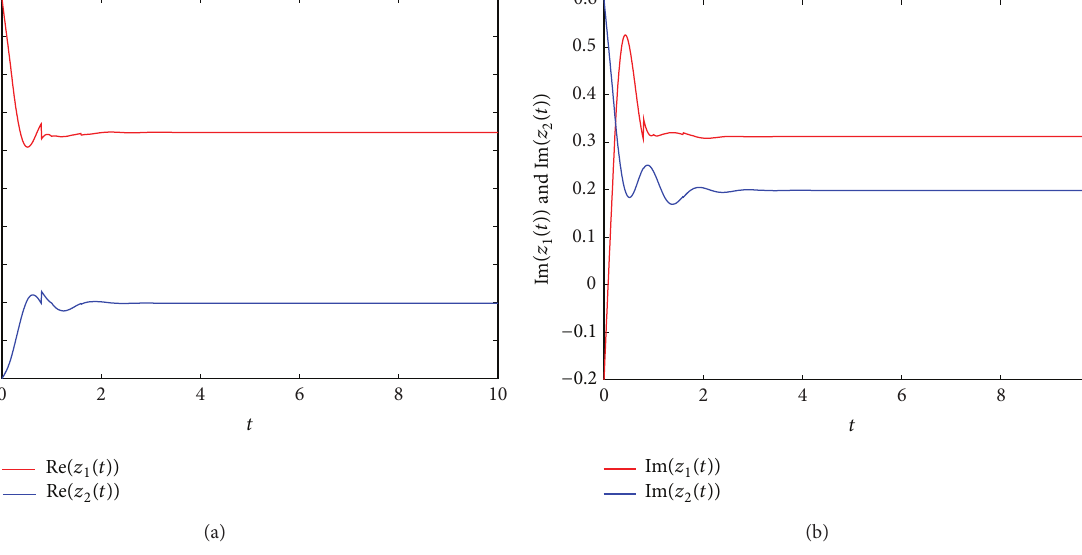
Figure 2: State trajectories of system (58) with 𝛿 = 0.2 .